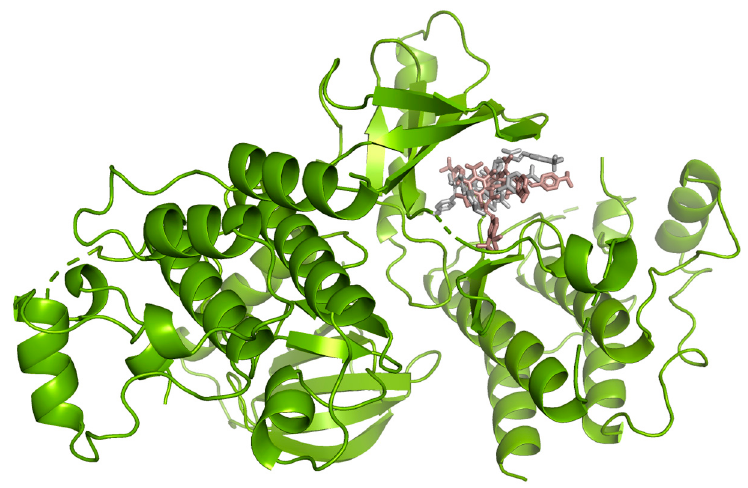
Figure 9. B-Raf kinase (PDB ID: 3OG7) in complex with vanicosides A (gray) and B (pink).